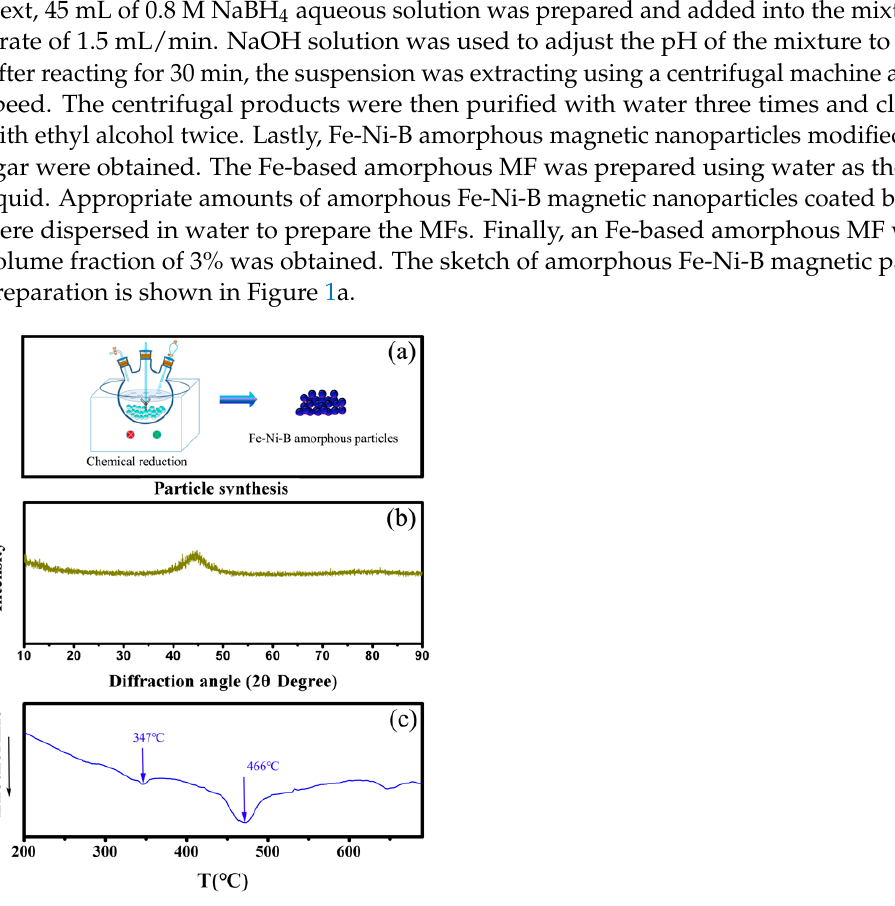
Figure 1. The sketch of Fe-Ni-B particle preparation ( a ); XRD patterns of Fe-Ni-B particles ( b ); DSC curves of Fe-Ni-B particles ( c ).